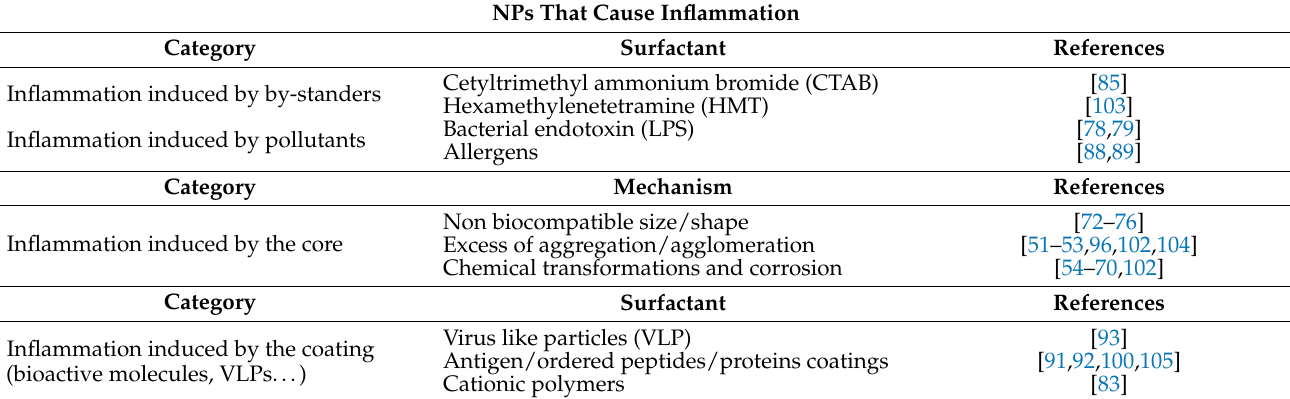
Table 2. Inflammatory activation induced by